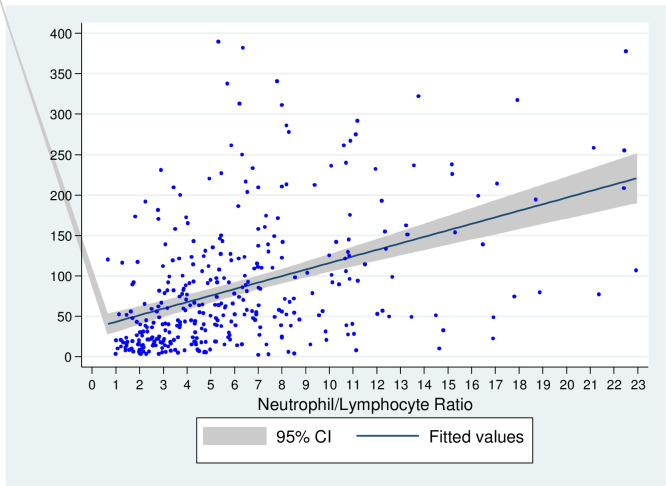
Correlation between IL-6 and NLR.Here we show the correlation between NLR and IL-6. The correlation produced a Spearman’s rho of 0.485, which was statistically significant with a p value of <0.001. Dots represent individual values.